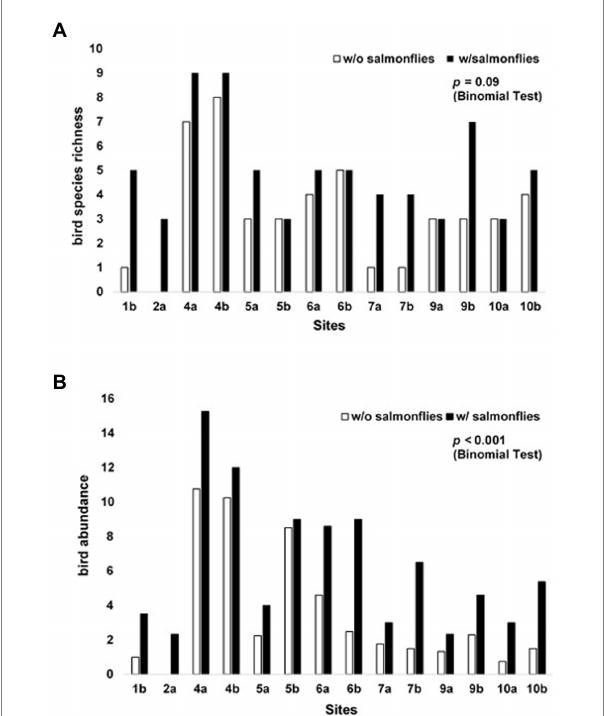
FIGURE 7 (A) Shifts in the average number of bird species (species richness), for the 10 species of birds observed feeding on salmonflies observed at each reach above and below the confluence when adult salmonflies were present vs. absent (binomial test p = 0.090) in the Salmon River Drainage and Henry’s Fork of the Snake River Drainage, Idaho, United States during May–June 2018. (B) Changes in average abundance of individual salmonfly-consuming birds among the 10